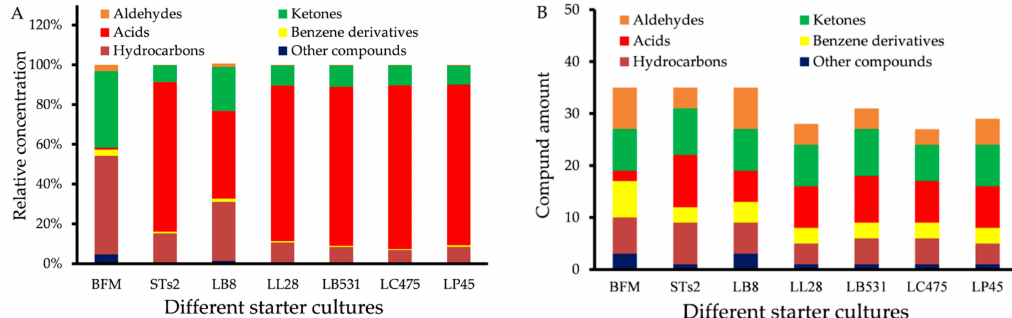
Figure 1. ( A ) Relative concentrations of di ff erent types of volatile compounds in milks fermented by di ff erent starter cultures. ( B ) Compound amount of di ff erent type volatile compounds in milks fermented by di ff erent starter